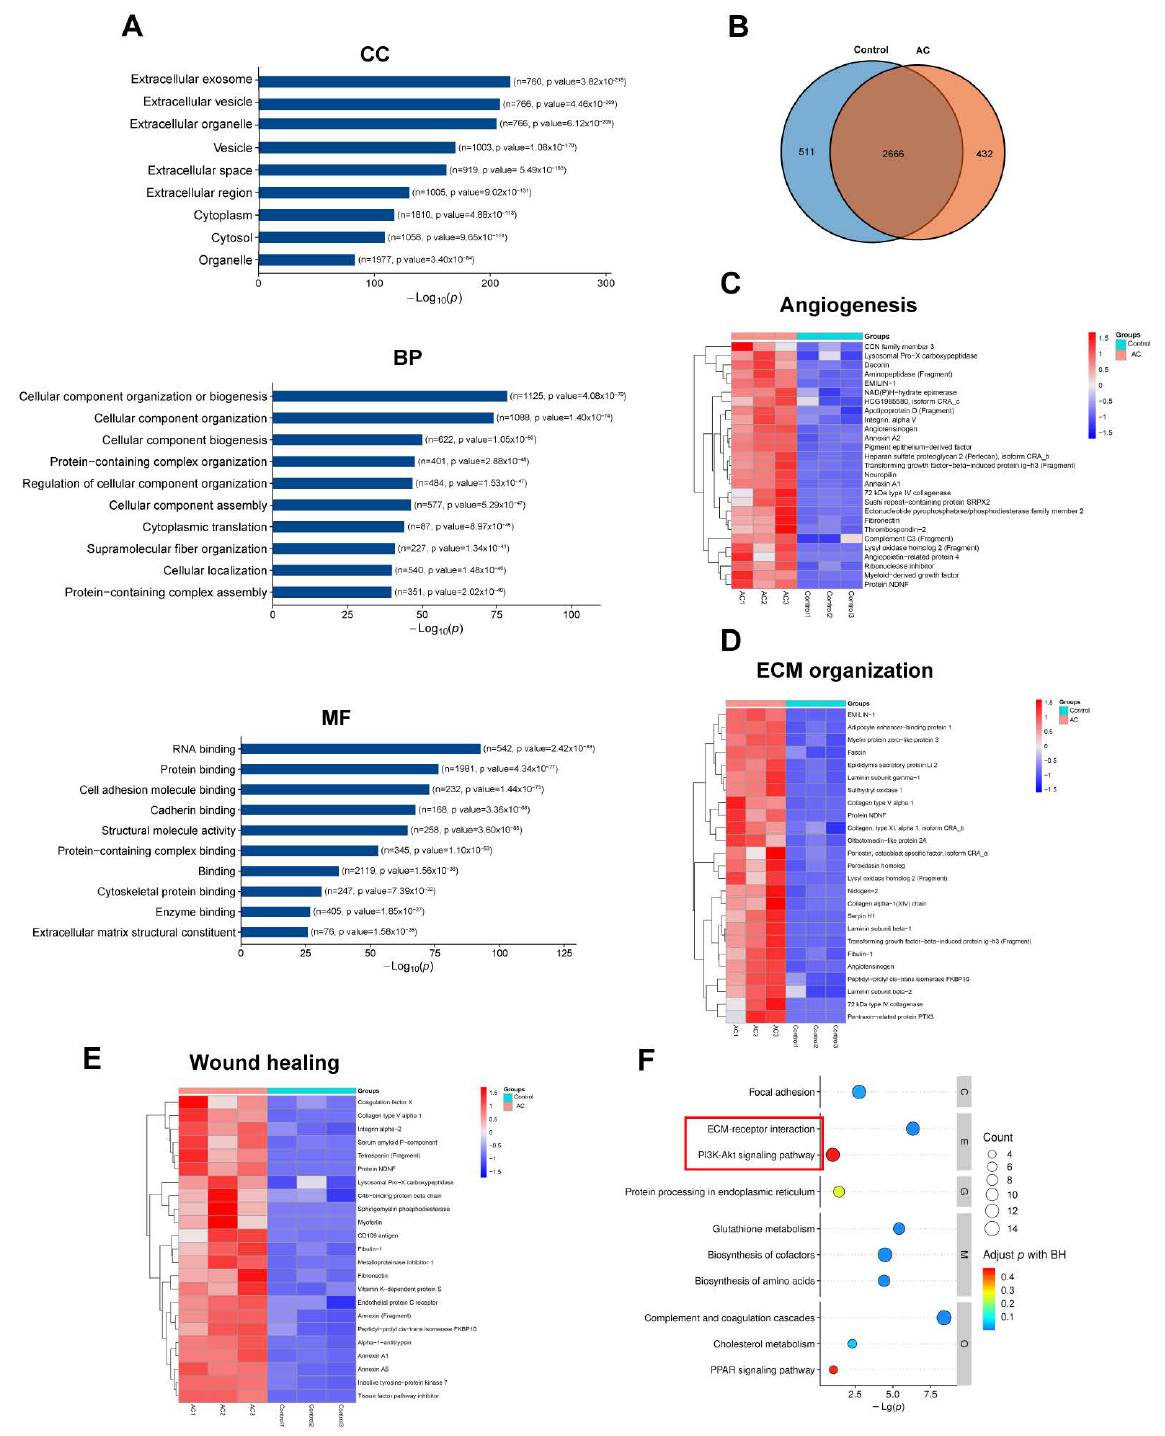
Figure 8. Proteomics of CON–ADSCs CM and AC–ADSCs CM. ( A ) GO analysis of all proteins in ADSCs CM. ( B ) Differential protein Venn diagram of CON–CM and AC–CM. ( C – E ) Heat maps of GO enrichment of CON–ADSCs and AC–ADSCs in Angiogenesis, Wound healing and ECM organization. ( F ) KEGG pathway enrichment analysis of upregulated proteins in AC–ADSC CM compared to CON–ADSC CM. Data are shown as mean ± SD. Independent-sample t test (two-tailed) was used for statistical comparisons between 2 groups; One-way ANOVA followed by Tukey post hoc test was used for statistical comparisons between multiple